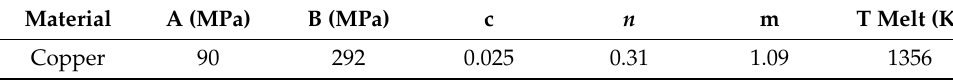
Table 2. Coefficients of Johnson-Cook model for copper [15].